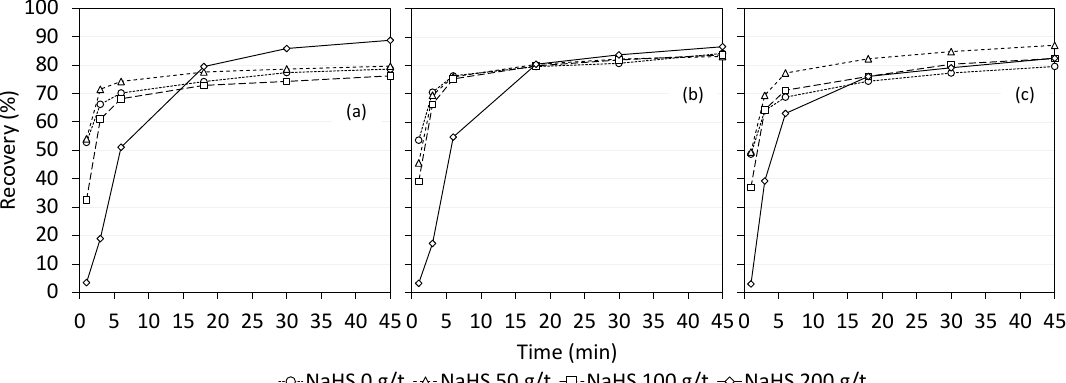
Figure 7. Bornite recoveries without NaHS and with NaHS dosages of 50 g/t, 100 g/t, and 200 g/t at